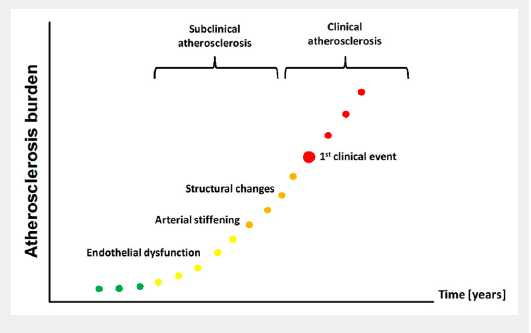
Atherosclerosis burden starts early in life. Endothelial dysfunction, arterial stiffening and structural alterations of the arterial wall represent early steps in the development of atherosclerosis that are already detectable in children known to be at increased cardiovascular risk later in